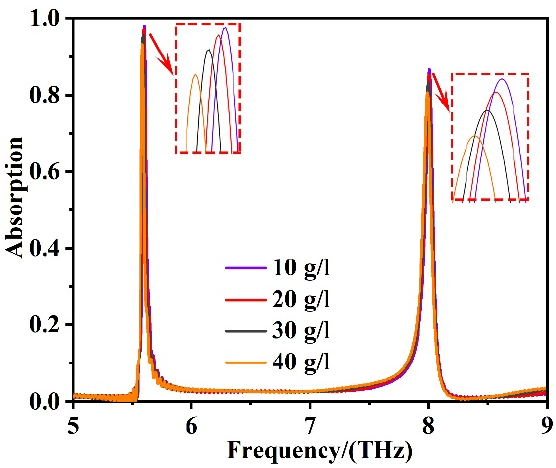
Figure 8. The wavelength changed at the two resonance frequencies when the hemoglobin molecular content increased successively from 10 g/L (n = 1.34), 20 g/L (n = 1.36), 30 g/L (n = 1.39) to 40 g/L (n = 1.43).